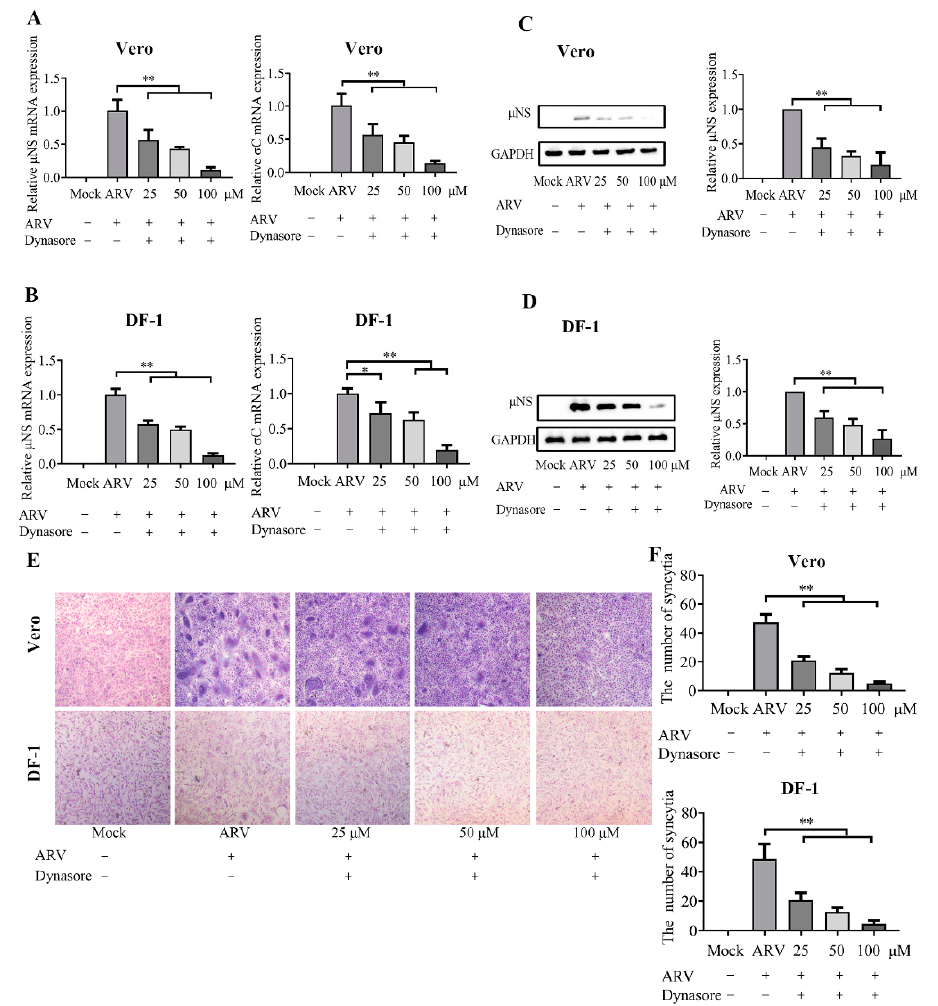
Figure 4. ARV internalization depends on dynamin. Vero and DF-1 cells were pretreated with the indicated concentrations of dynasore (25, 50, 100 μ M) for 1 h and incubated with ARV (10 MOI) for 1 h at 37 °C. The bound but unpenetrated virions were inactivated with citrate buffer. ( A ) The mRNA expression levels of the ARV- μ NS and σ C genes in Vero cells were determined by qRT-PCR at 9 hpi. ( B ) The mRNA expression levels of the ARV- µ NS and σ C genes in DF-1 cells were determined by qRT-PCR at 9 hpi. ( C , D ) The level of ARV μ NS protein in Vero ( C ) and DF-1 ( D ) cells was analyzed by Western blotting at 9 hpi. ImageJ software was used to analyze the relative levels of μ NS protein in comparison with ARV group that without drug treatment, and the ratios from three independent experiments are displayed as fold changes in the histograms. ( E ) The level of syncytium formation in Vero and DF-1 cells was detected by Giemsa-staining at 12 hpi. Images were cap- tured on an inverted microscope at 10× objective. ( F ) The number of syncytia per microscopic field in Vero and DF-1 cells. Results are presented as the means ± SD of data from three independent experiments. *, p < 0.05; **, p < 0.01.